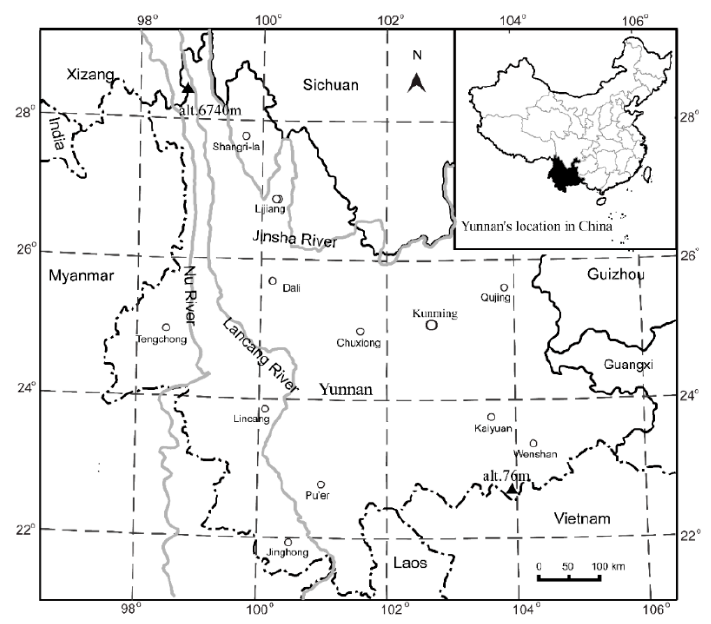
Figure 1. Map of the study area. Insert in top-right corner shows location of Yunnan Province within China. The triangles ( ▲ ) show the lowest and highest altitudes (alt.) in the area, respectively.